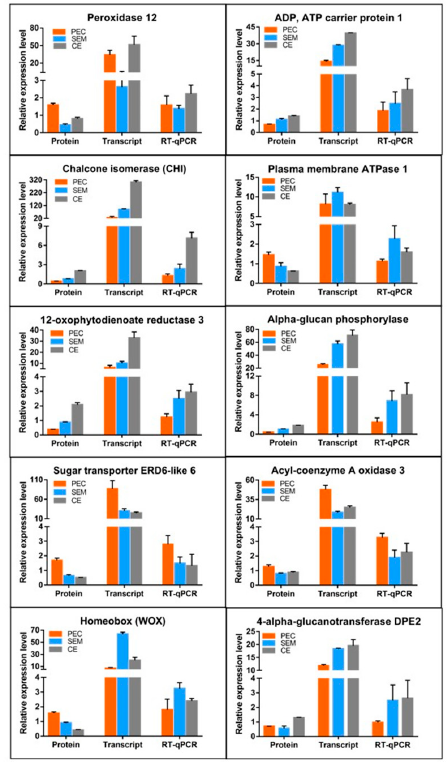
Figure 5. Relative expression levels of DEPs in the proteome and the expression of their corresponding transcripts in the transcriptome, according to RT ‐ qPCR.